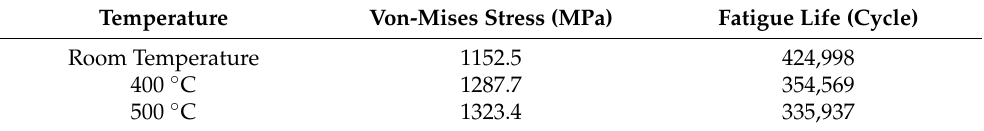
Figure 32. Results of the fatigue analysis of stem at 500 °C. Table 10. Von-mises stress and fatigue life results according to the temperature change of the